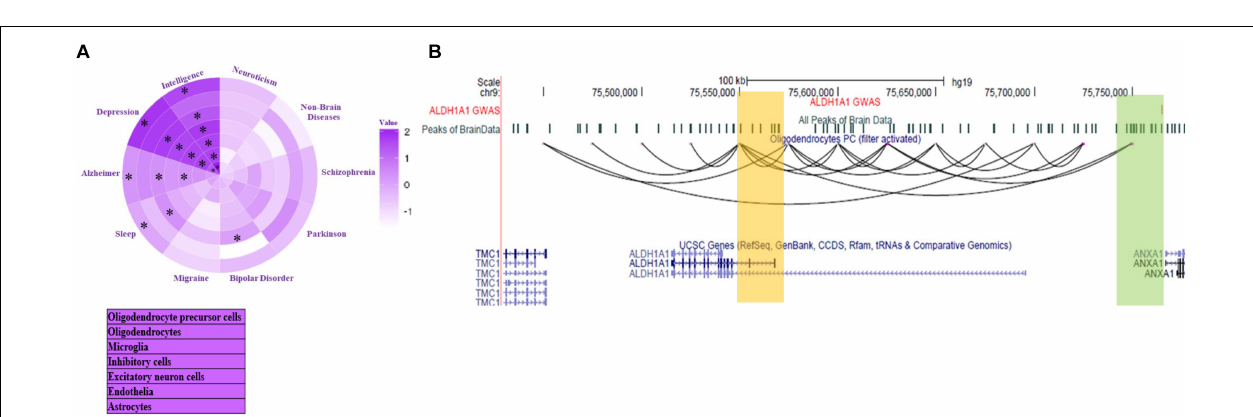
FIGURE 4 | Inference about target genes for disease-associated mutations in Brain cells. (A) Enrichment of interaction among GWAS loci associated with mental disorder and gene promoters in seven brain cell-type. Star (*) represents p < 0.05. The p -value calculation was done using two proportion z -test. (B) The UCSC browser snapshot showing estimated chromatin interaction between the region with GWAS SNP (rs3758354) and promoter of ALDH1A1 gene in oligodendrocyte precursors